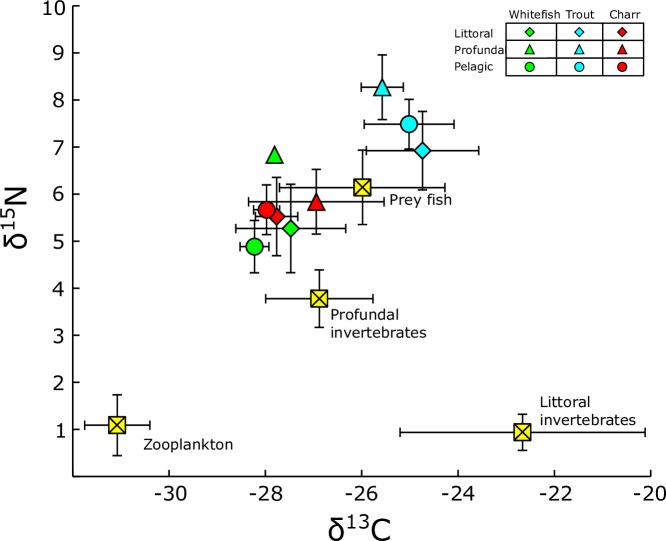
Bi-plot signatures of δ15N and δ13C stable isotopes.Average (±SD) stable isotope values of the three fish species caught from different habitats in Lake Fyresvatn and their main dietary sources. Trout diet consists of fish (whitefish, charr and juvenile trout), benthic invertebrates and zooplankton. Diet of whitefish and charr consisted of profundal invertebrates, littoral invertebrates and zooplankton.